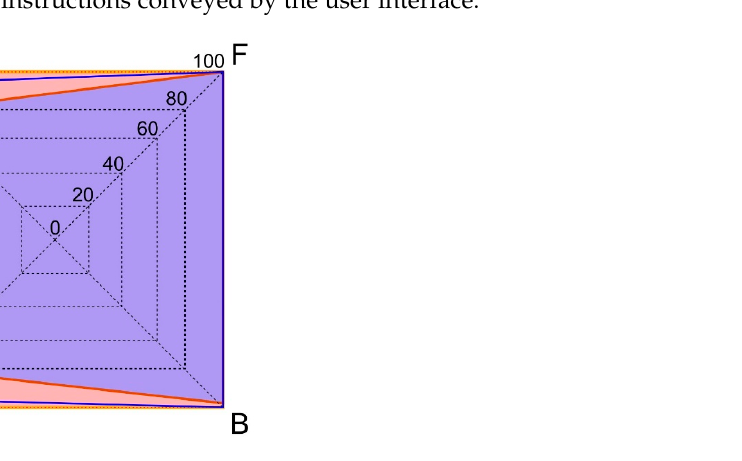
Figure 6. Comparative performance between the subjects with the best and worst scores. Best per- formance: outer orange area. Worst performance: inner purple area. Mean performance: blue line.